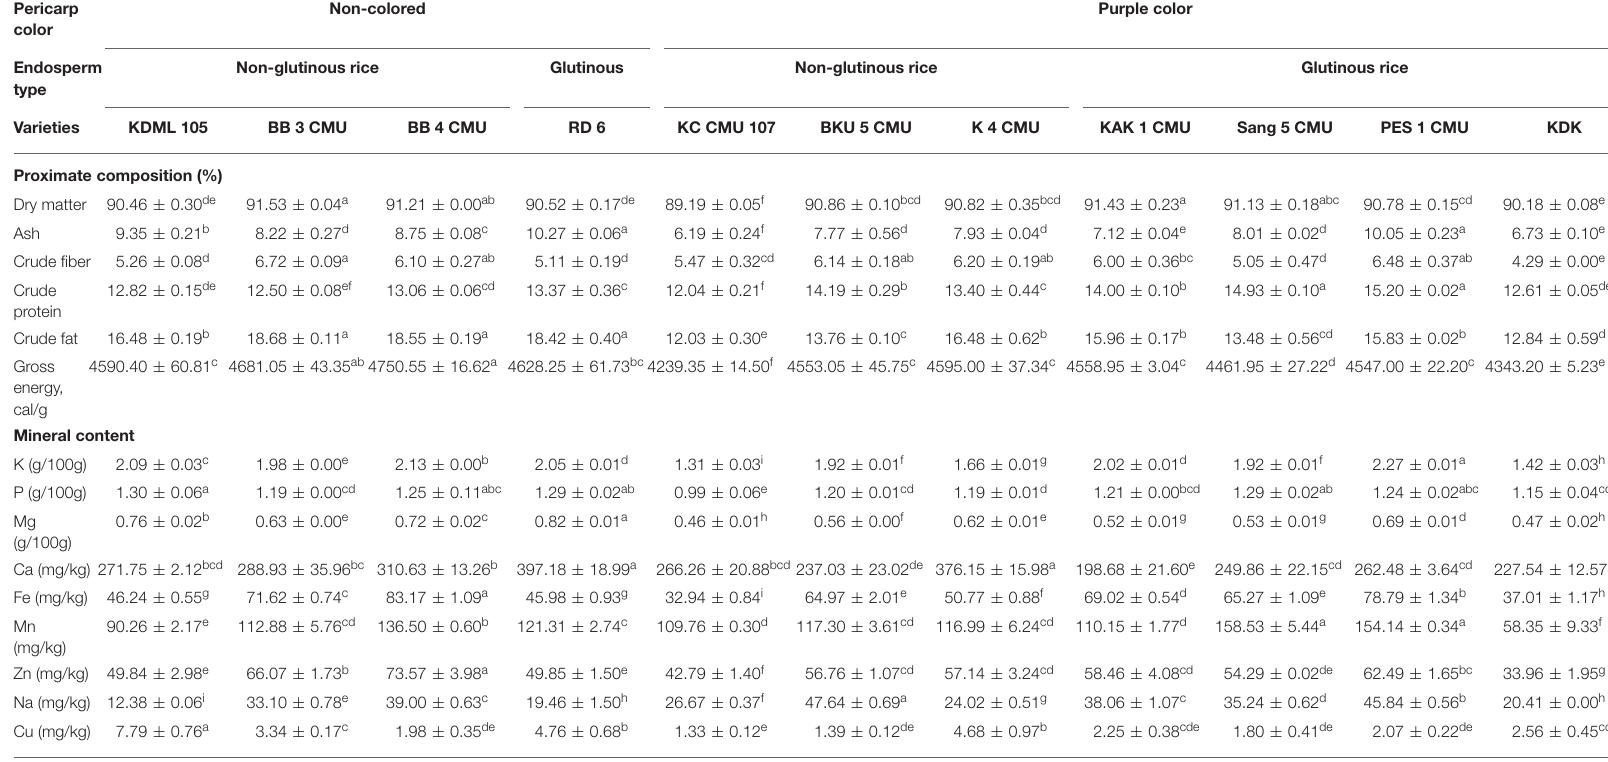
TABLE 2 | Proximate and mineral content of rice bran